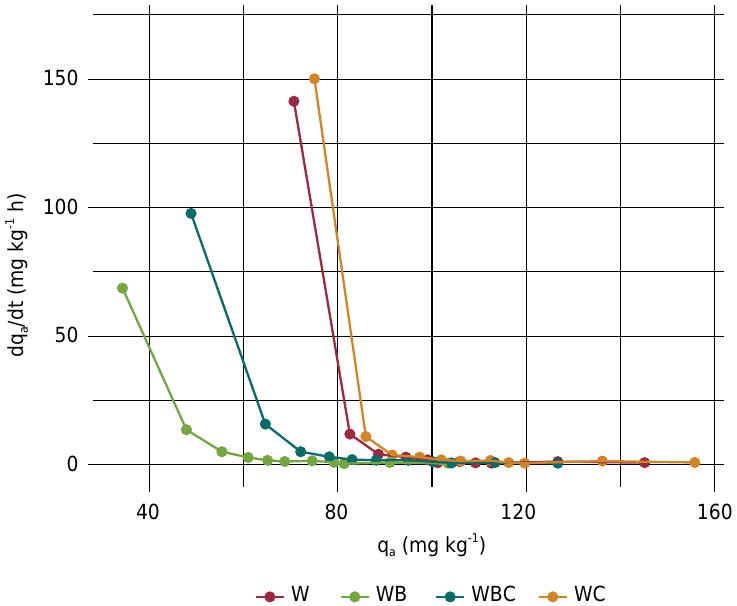
Figure 4. Phosphorus sorption rates in Fe mining waste (W) enriched with organic compost (WC), biochar (WB), and a combination of both amendments